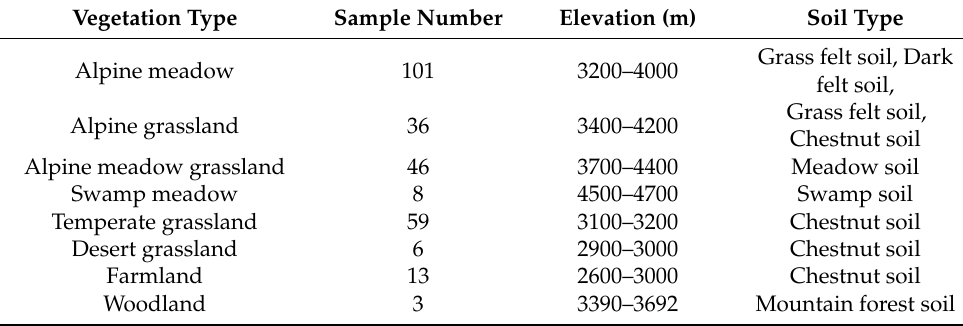
Table 1. Numbers of samples and soil type for each vegetation